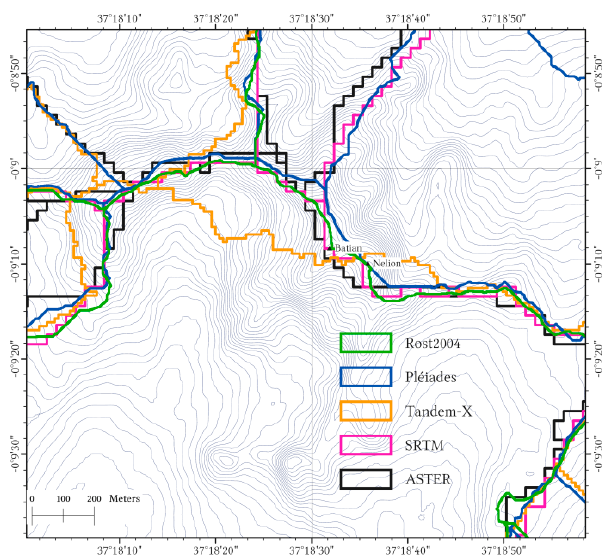
Figure 6. Representation of basin borders derived from the individual DEMs. Contours are taken from the 2004 map (Rost2004). Additionally, basin borders derived from widely used coarser global DEMs (cell size 30 m) SRTM (version 2) and the ASTER (GDEM version 2) are shown (both products are freely available from the U.S. Geological Survey via EarthExplorer (https://earthexplorer.usgs.gov/).